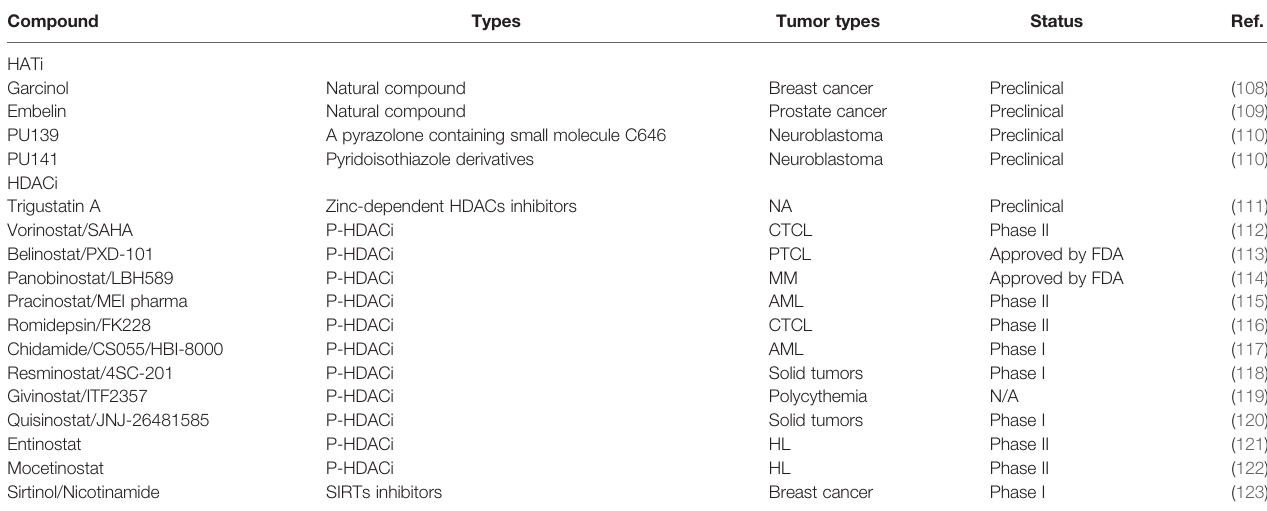
TABLE 3 | Compounds targeting histone acetylation exert anti-tumor